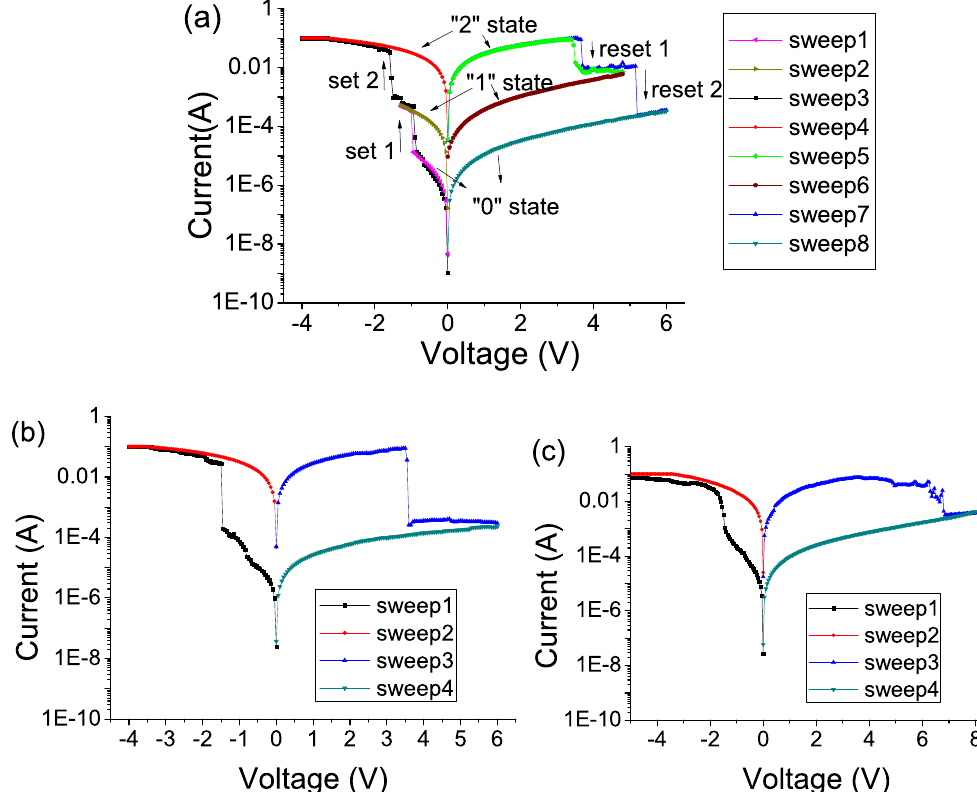
Figure 2. ( a ) The I - V characteristics of the ITO/PS + GO/Al device. ( b ) The I - V characteristics of the ITO/GO/ Al device. ( c ) The I - V characteristics of the ITO/PS/Al